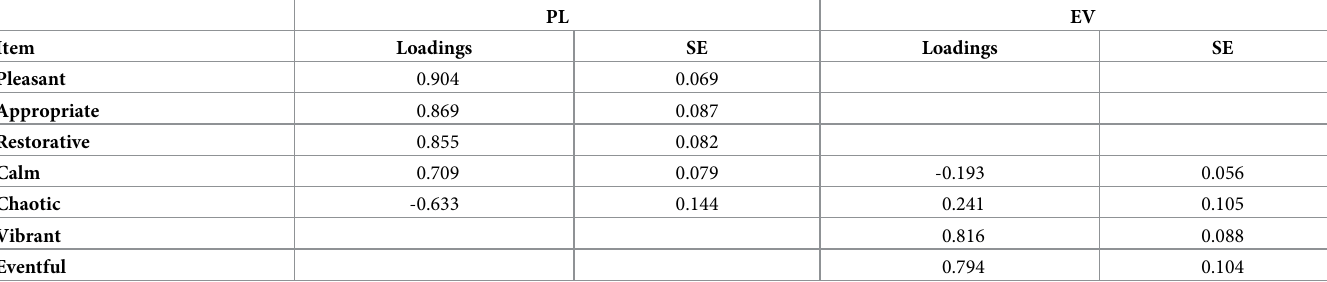
Table 5. Factor loadings and standard errors (SE) for the retained CFA model for laboratory data (N =